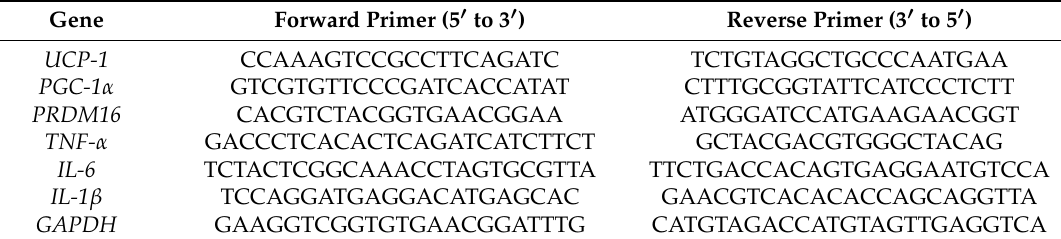
Table 2. Primer sequences used in quantitative real-time